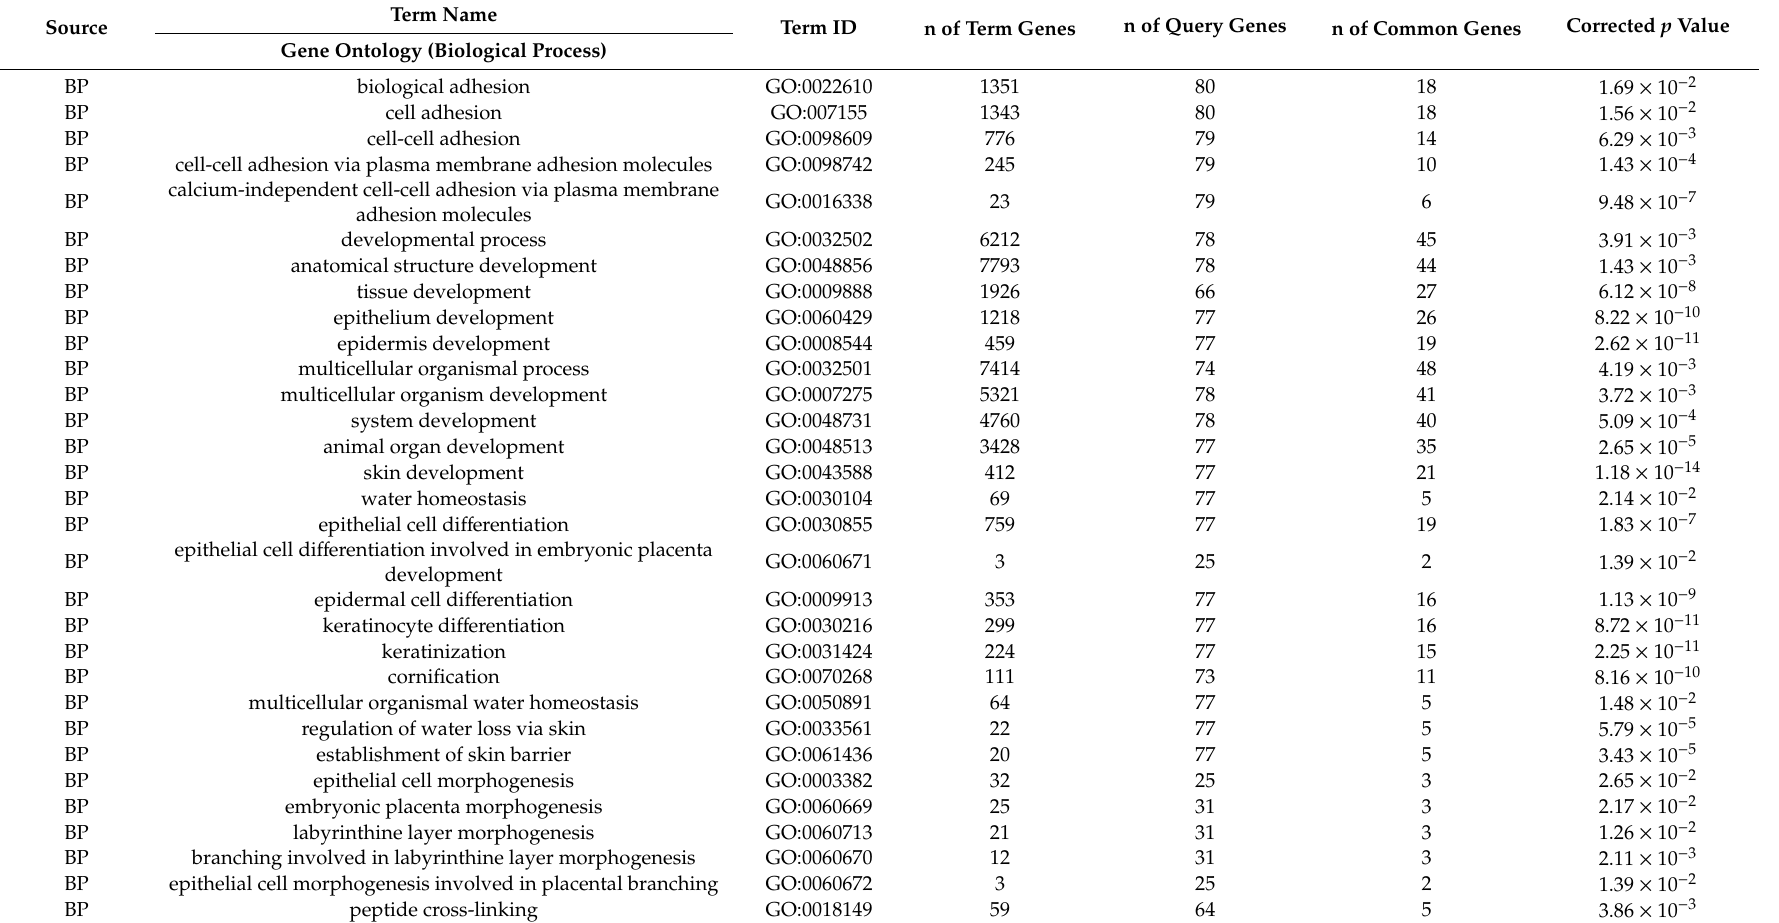
Table 3. Gene Ontology (GO) analysis of the most di ff erentially regulated cellular processes in all biological contexts, following modulation of grh / Grhl function. Functional Gene Ontology (GO) annotations are over-represented among the 200 genes positively regulated by grh / grhl, with the highest evidence of regulation across all species (highest fold change score aggregated over all the